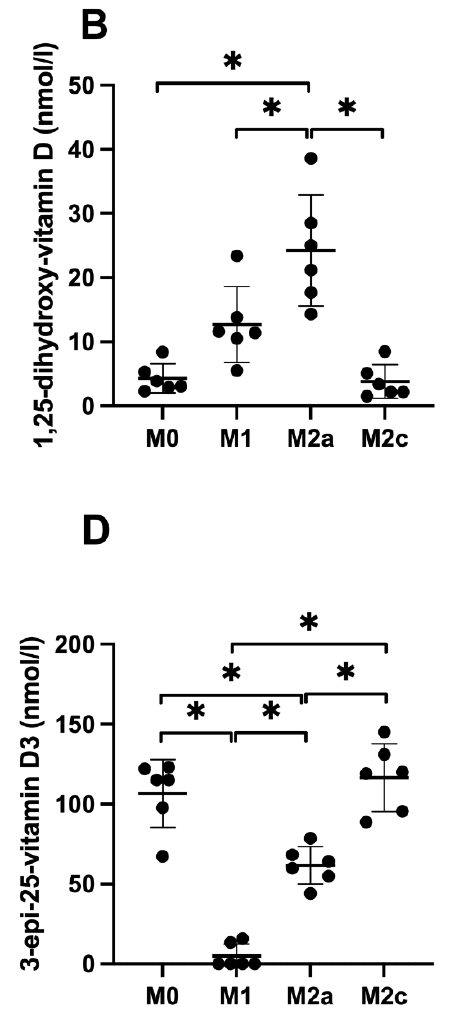
Figure 2. Vitamin D metabolites in polarized MDMs after vitamin D stimulation . MDMs were polarized into M0, M1, M2a and M2c MDMs and stimulated with 1000 nM 25-hydroxy-vitamin D. Concentrations of vitamin D metabolites in the different subtypes of MDMs were measured in the media after 24 h: 25-hydroxy-vitamin D ( A ), 1,25-dihydroxy-vitamin D ( B ), 24,25-dihydroxy-vitamin D ( C ) and 3-epi-25-hydroxy-vitamin D ( D ). * Indicates statistically significant differences between groups (subtypes) on each graph.